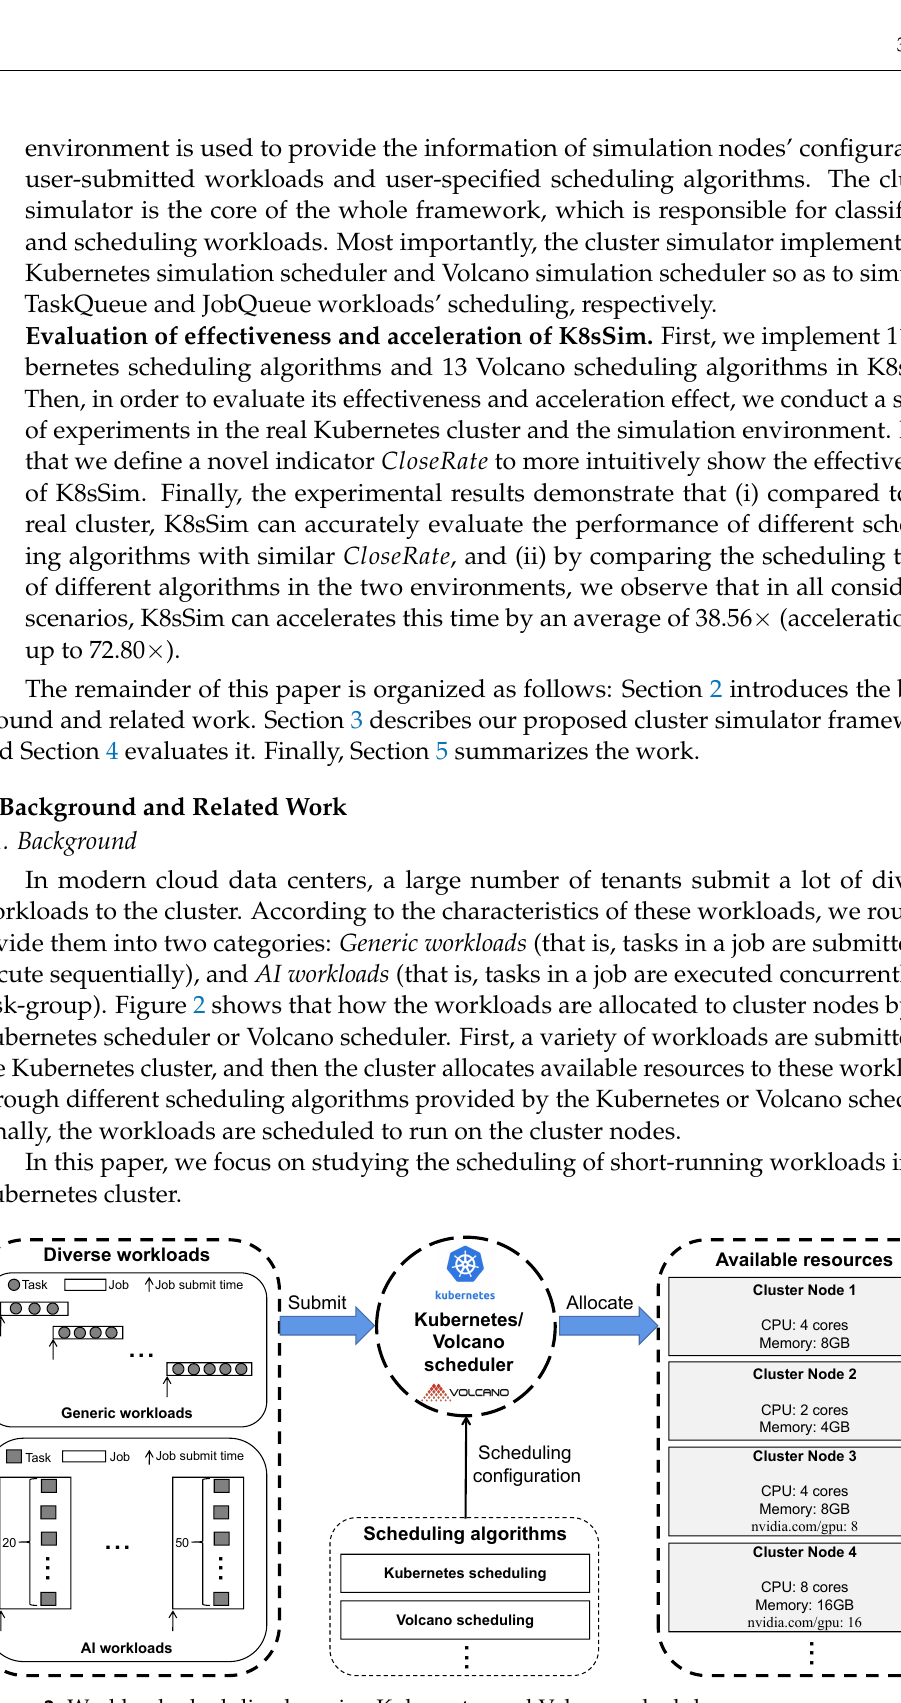
Figure 2. Workload scheduling by using Kubernetes and Volcano